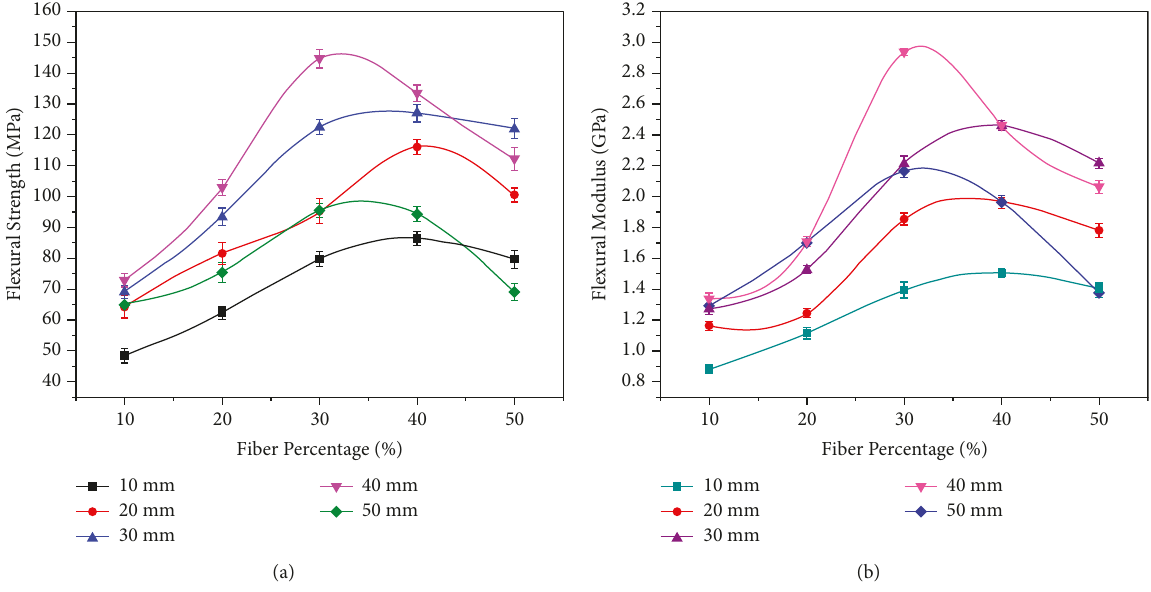
Figure 3: Effect of fiber length and weight percentage on (a) flexural strength and (b) flexural modulus.